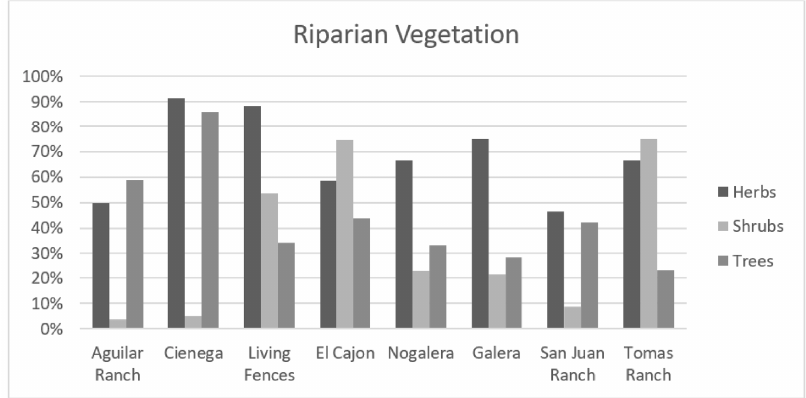
Figure 4. Cover percentage for vegetation strata on the riparian vegetation stands.